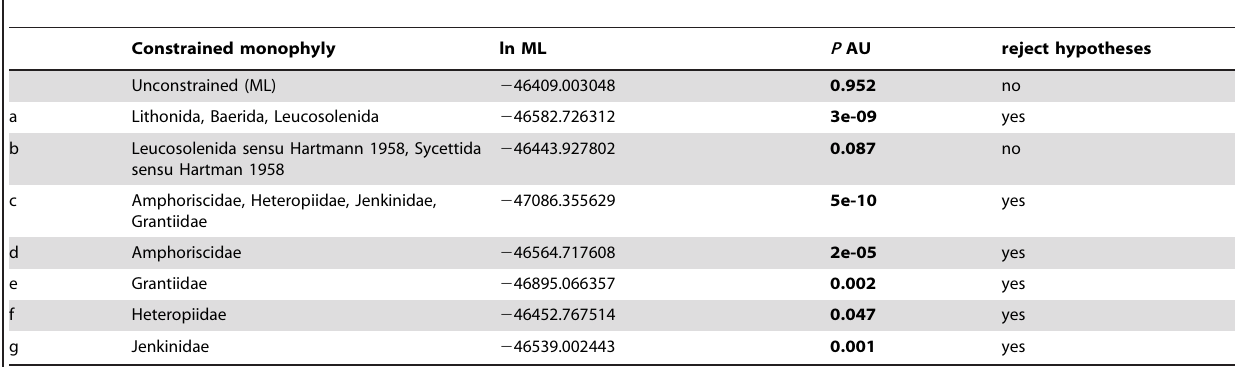
Table 3. p-values for the approximately unbiased test [47] for different topological constrains in